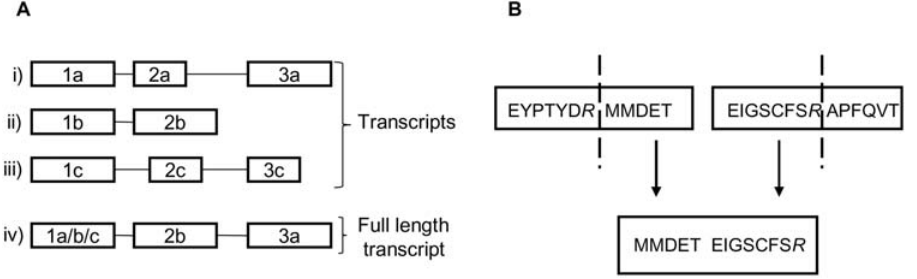
Figure 2. Generation and usage of the SkipE database. (A) Generation of representative transcripts. Each box represents an exon and each line is an intron. i), ii) and iii) represent transcripts from a single gene. iv) shows the full length representative transcript used to generate the junction peptides. (B) Structure of a junction peptide. The top two boxes represent the translated sequences of two separate, non-adjacent exons. The tryptic cleavage sites are represented by dashed vertical bars. The C-terminal sequence of the upstream exon from the final tryptic site is spliced to the N- terminus of the downstream exon and extends to the first tryptic cleavage site of the downstream exon.